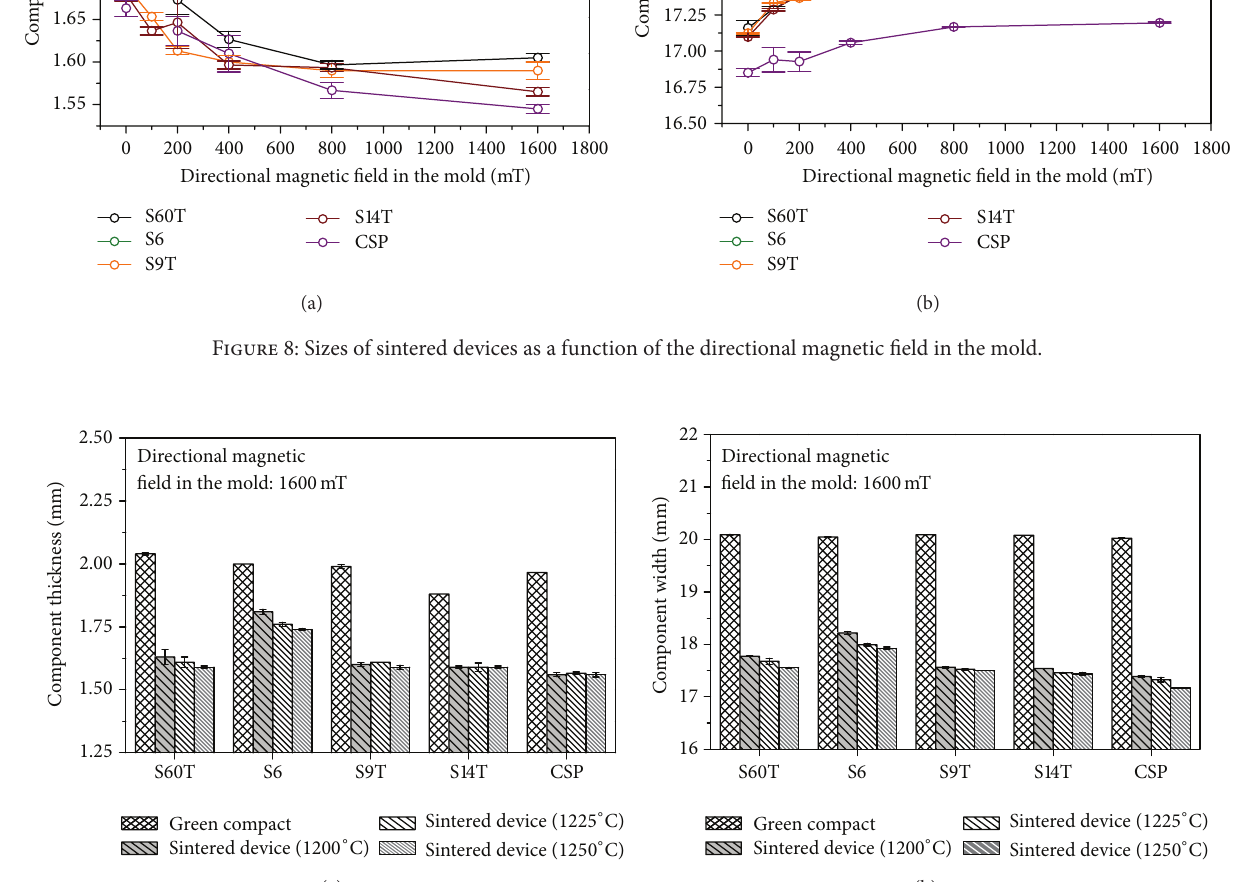
of sintered magnets in the powder injection molding process is possible and yields promising